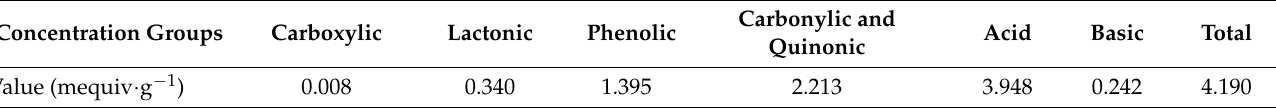
Table 2. Concentration of acidic and basic groups on ALP surface.